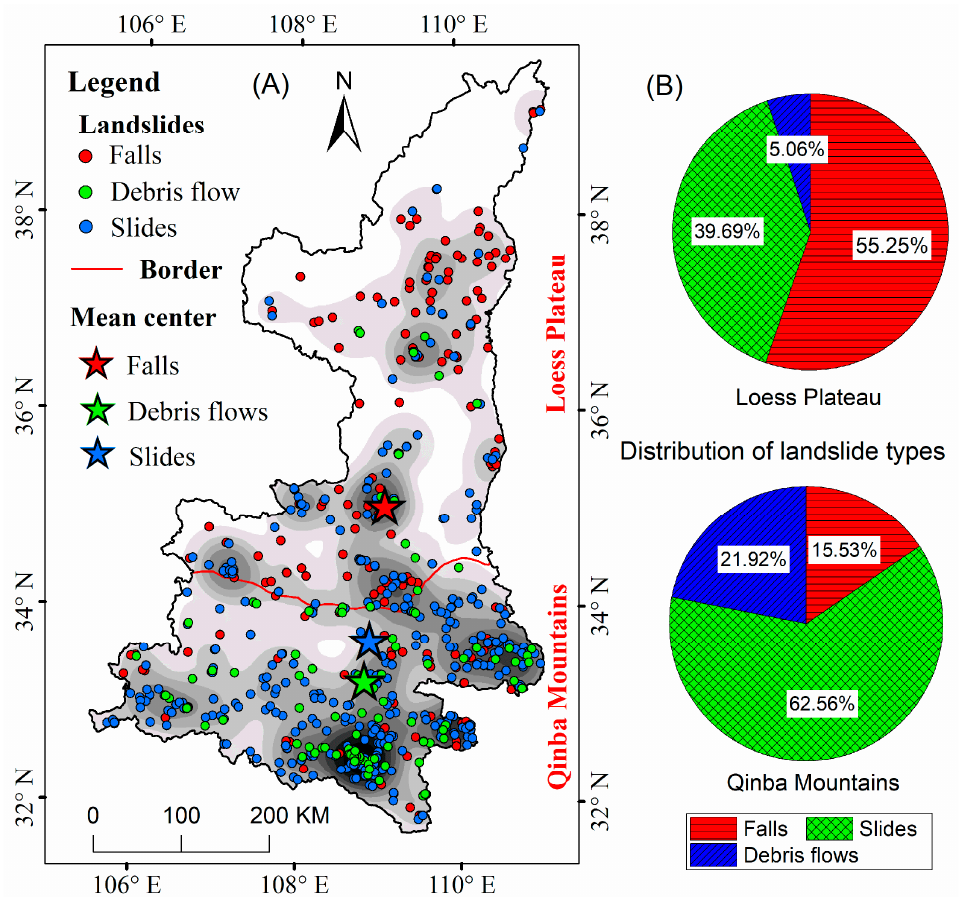
Figure 10. Distribution of the kernel density ( A ), mean center ( A ), and landslide type ( B ).